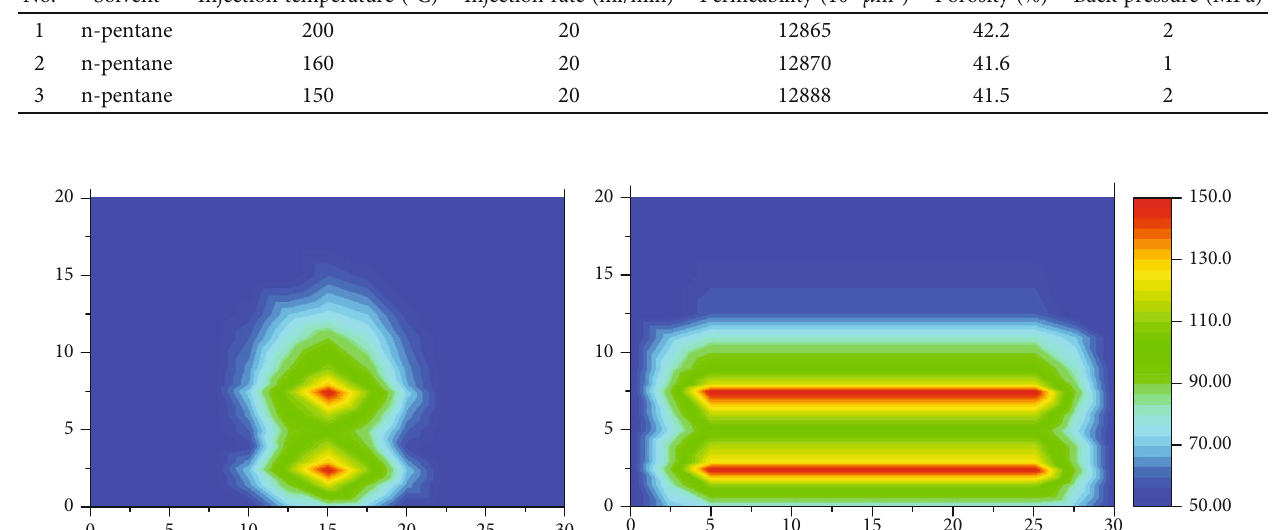
Figure 3: Temperature fi eld in the 3D model at the end of the interwell warm-up stage: (a) in the vertical direction of the wells and (b) along the wells.